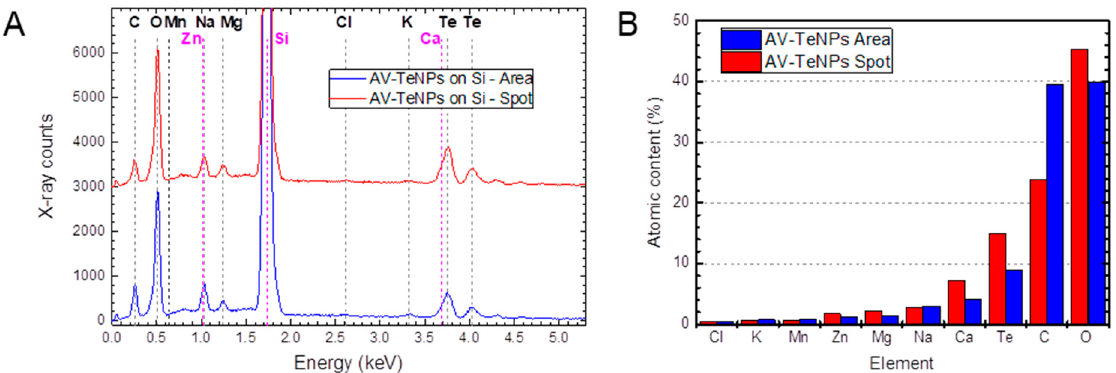
Figure A5. Energy-dispersive X-ray spectroscopy (EDX) characterization of the AV-TeNPs showing the presence of Te within the sample, as well as other elements corresponding to the reactants. ( A ) X-ray spectra, taken in different zones: spot corresponds to the big TeNP surrounded by the red circle in Figure A4A, and the area corresponds to the whole same image. The elements corresponding to the detected peaks are indicated in the graph. ( B ) Quantification of the elements is obtained from the spectra. As can be observed, the Te concentration is higher on top of the observed NP, corroborating their assignment as TeNPs.